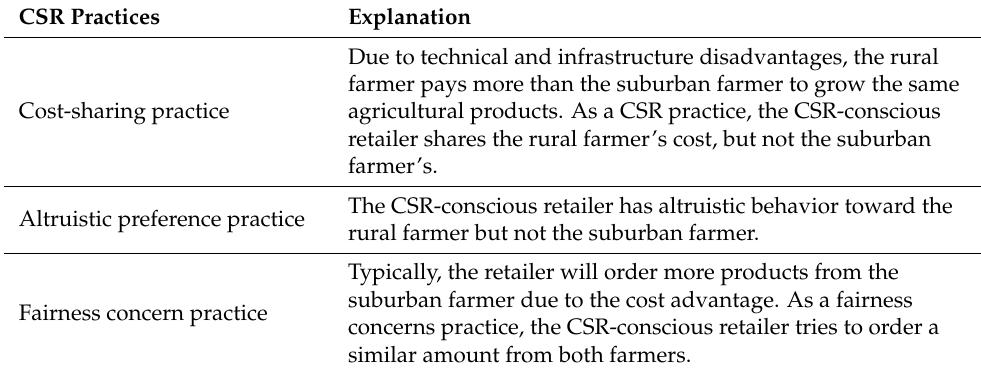
Table 2. Explanation of CSR practices.